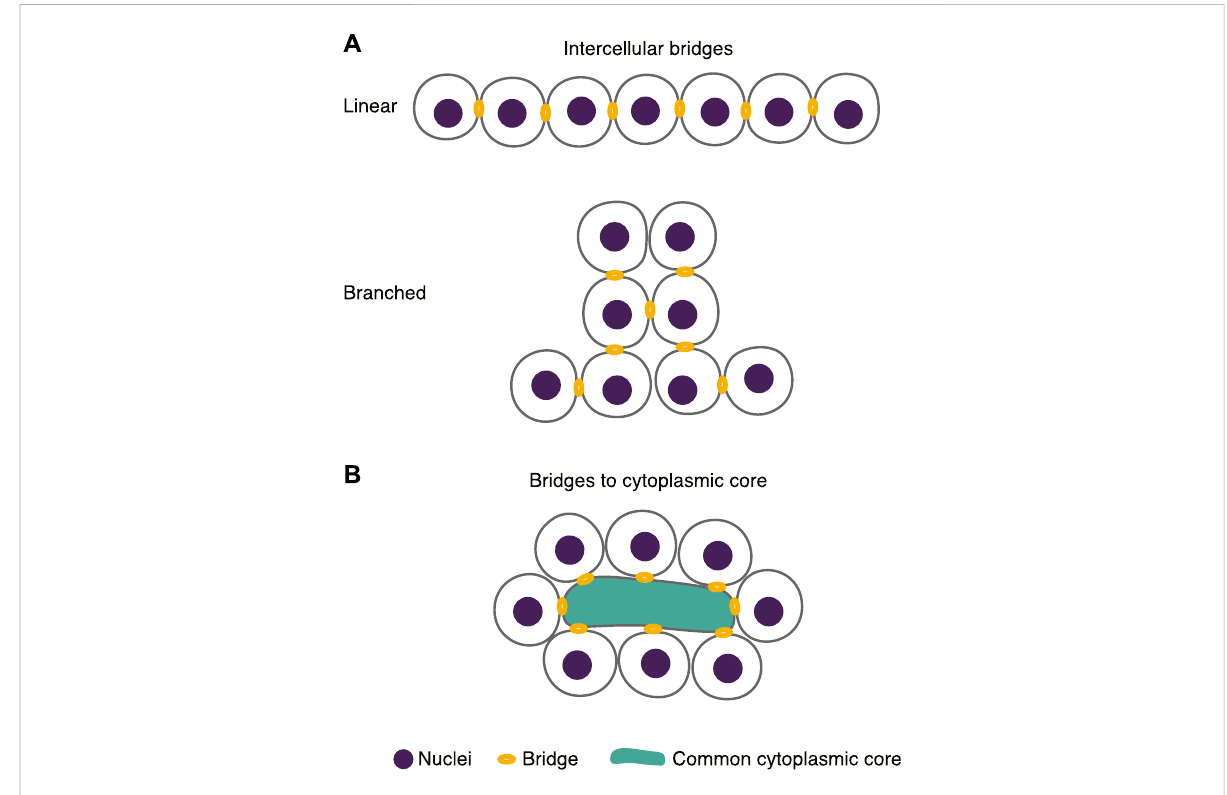
FIGURE 1 Germlinesyncytiavaryinarchitecture. (A) Germlinesyncytiaformedbyintercellularbridgesthatdirectlyconnectgermcells.Thesesyncytiacan be linear (upper) or branched (lower), depending on the number of bridges per cell. (B) Germline syncytia formed by cytoplasmic bridges that connect germ cells to a common cytoplasmic